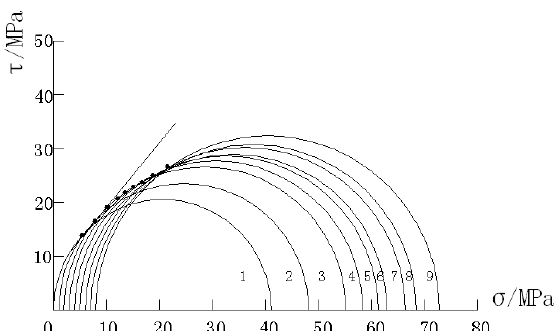
Figure 3. The Mohr stress circles and shear strength envelope of AC-13C.